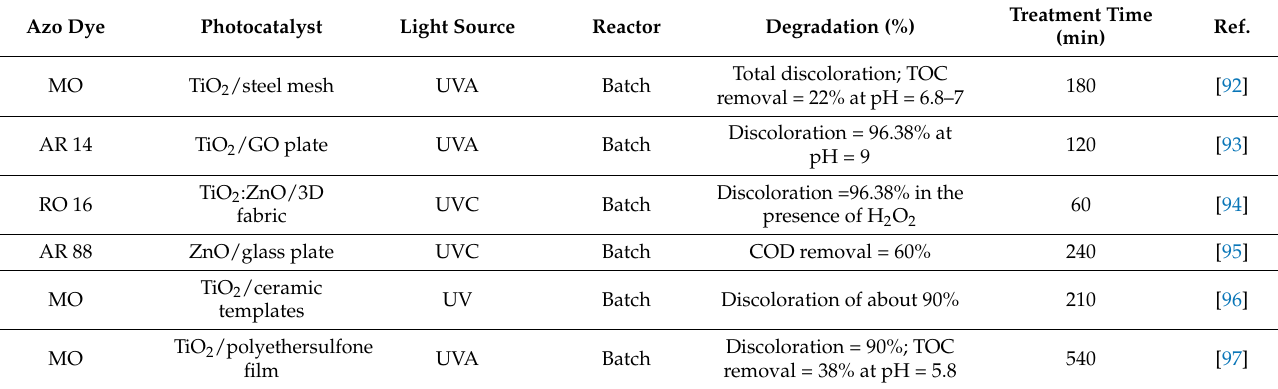
Table 1. Catalytic performances of different photocatalysts immobilized on macroscopic supports. AO = Acid Orange; AR = Acid Red; COD = chemical oxygen demand; EB-T = Eriochrome Black T; MO = Methyl Orange; NR = Novacron Red; RO = Reactive Orange; TOC = total organic carbon; WW =